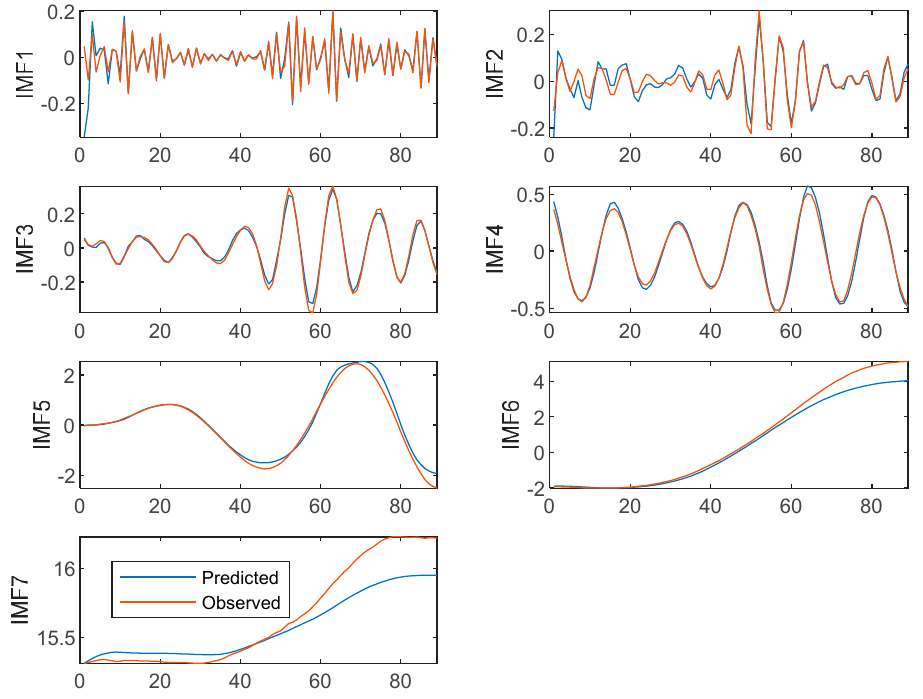
Figure 6. Fitting results of IMF components in grass carp price dataset.